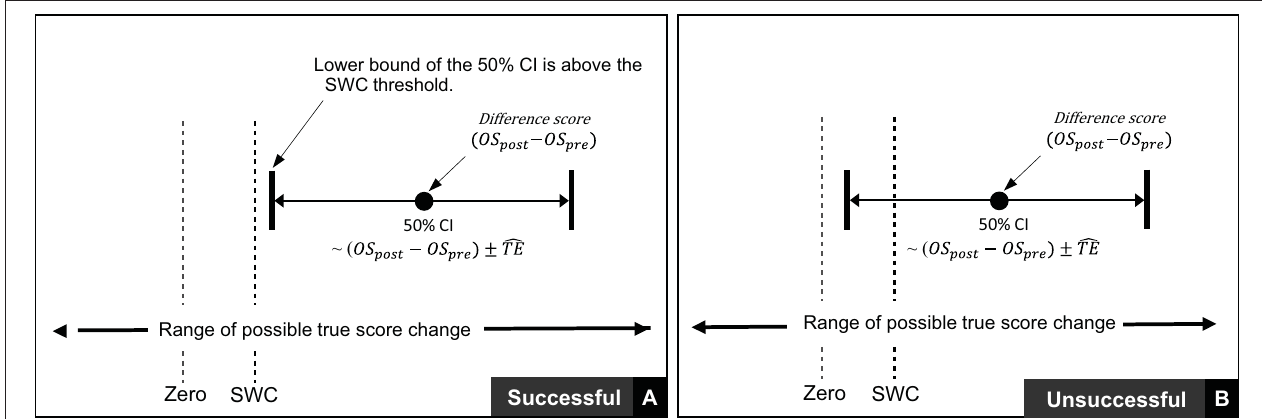
FIGURE 5 | Interpretation of true score change confidence intervals using smallest worthwhile change. observed score improvement of at least 1.6